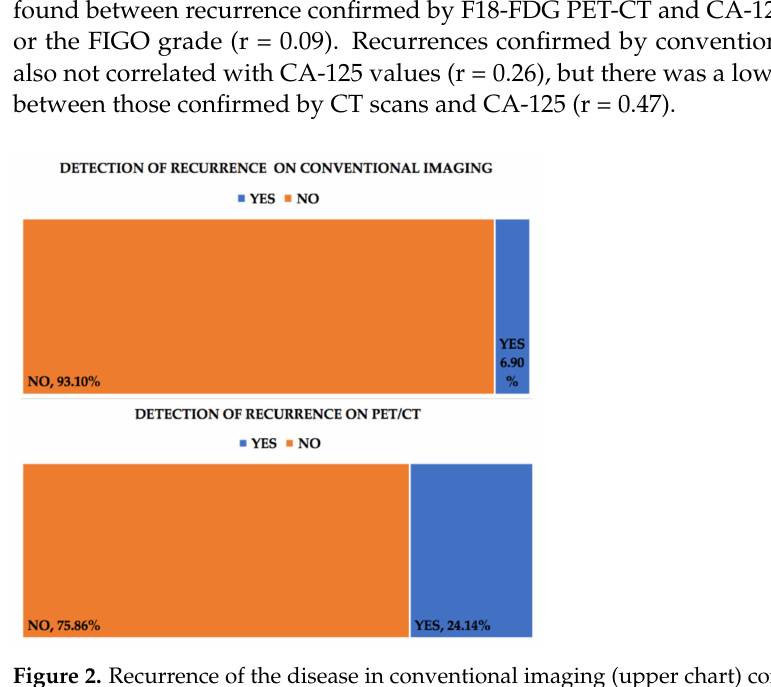
Figure 2. Recurrence of the disease in conventional imaging (upper chart) compared with F18-FDG PET-CT (lower